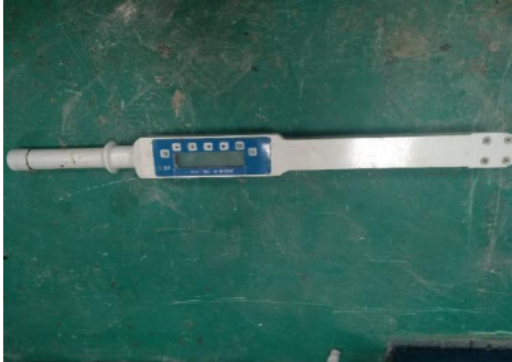
Figure 6. CML300 torque wrench.